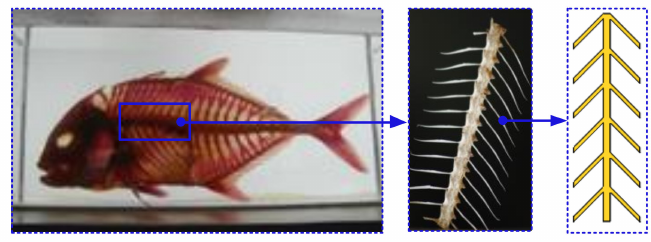
Figure 12. The schematic diagram of fishbone